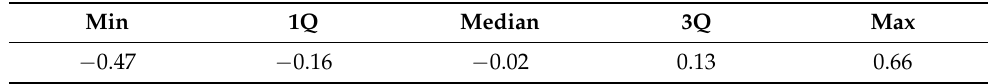
Table 5. Five-point table of the second linear model’s residuals.